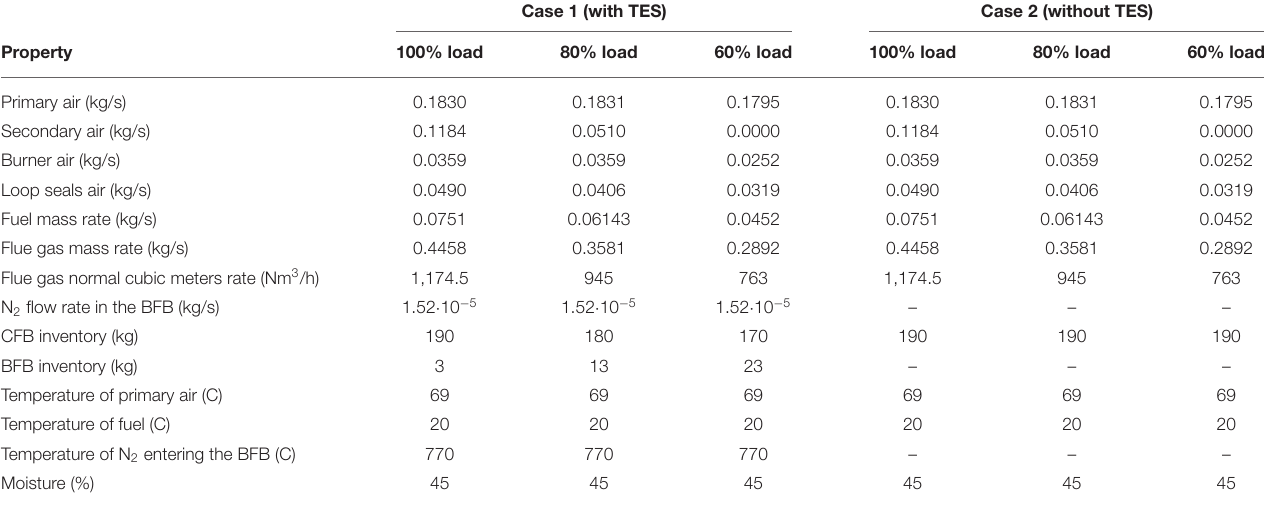
TABLE 3 | Operational data of the two simulation cases for the TES